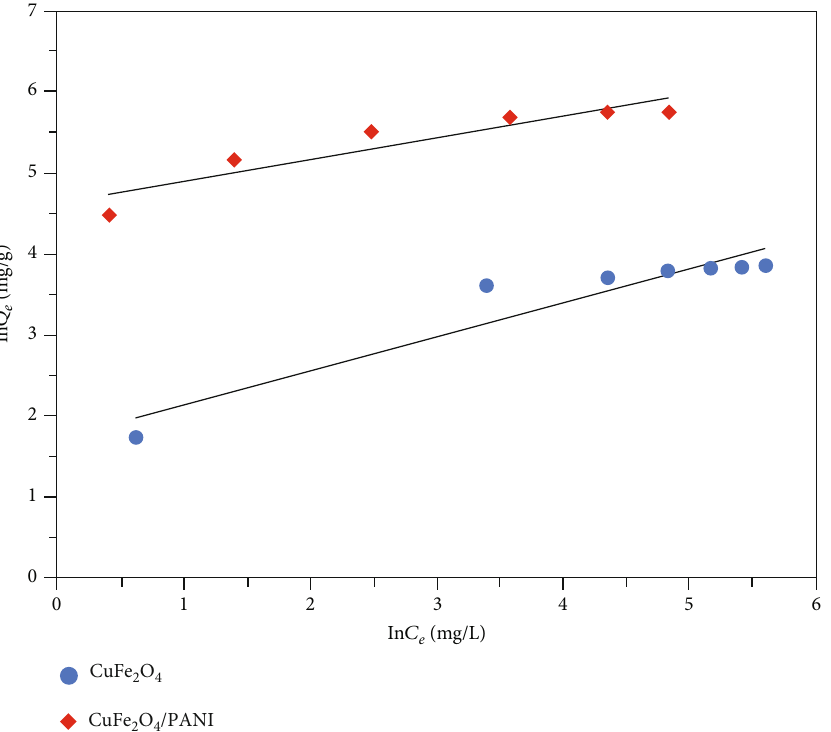
Figure 13: Fitting curves of Freundlich isotherm adsorption model for uranium on CuFe